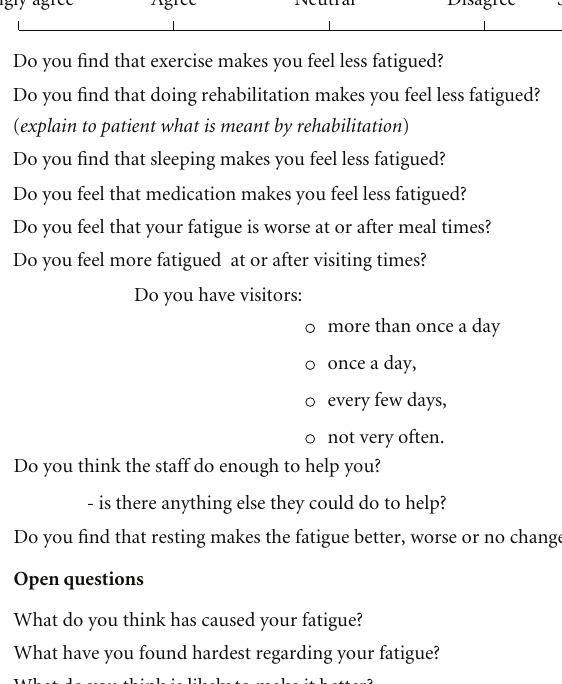
Figure 4: Interview